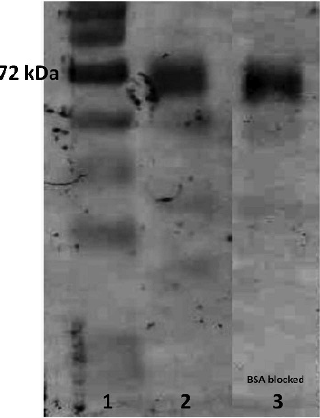
Figure 2 - Purified beta-lactoglobulin electroblotted on 0.45- m m pore-size nitrocellulose membranes after incubation with patient’s serum, primary antibody (goat IgG anti-human IgE), secondary antibody (HRP-conjugated rabbit anti-goat IgG) and DAB revelation. Immunoblot membranes exhibited bands of s- IgE against b -lactoglobulin ( b -Lg). Lane 1: Molecular weight ladder (10 to 170 kDa); Lane 2: distinct band at 72 kDa in a patient from group A; and Lane 3: distinct band at 72 kDa from the same patient after ex vivo serum competition with BSA.